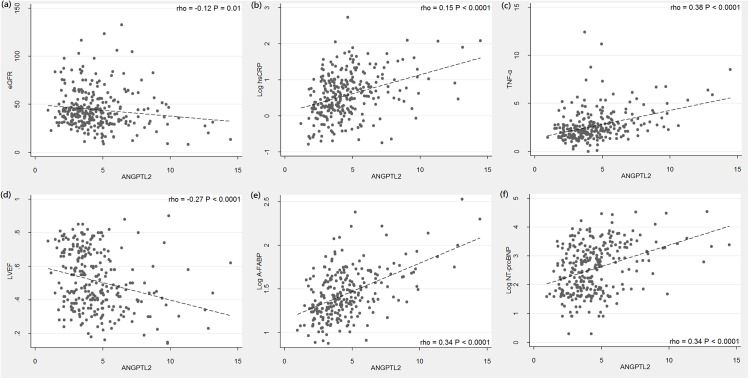
Scatter plot showing the relationship between serum ANGPTL2 levels and other clinical parameters.ANGPTL2 levels were positively correlated with hsCRP, TNF-α, A-FABP, NT-proBNP, and negatively correlated with eGFR and LVEF. (The Spearman correlation coefficients rho are presented).